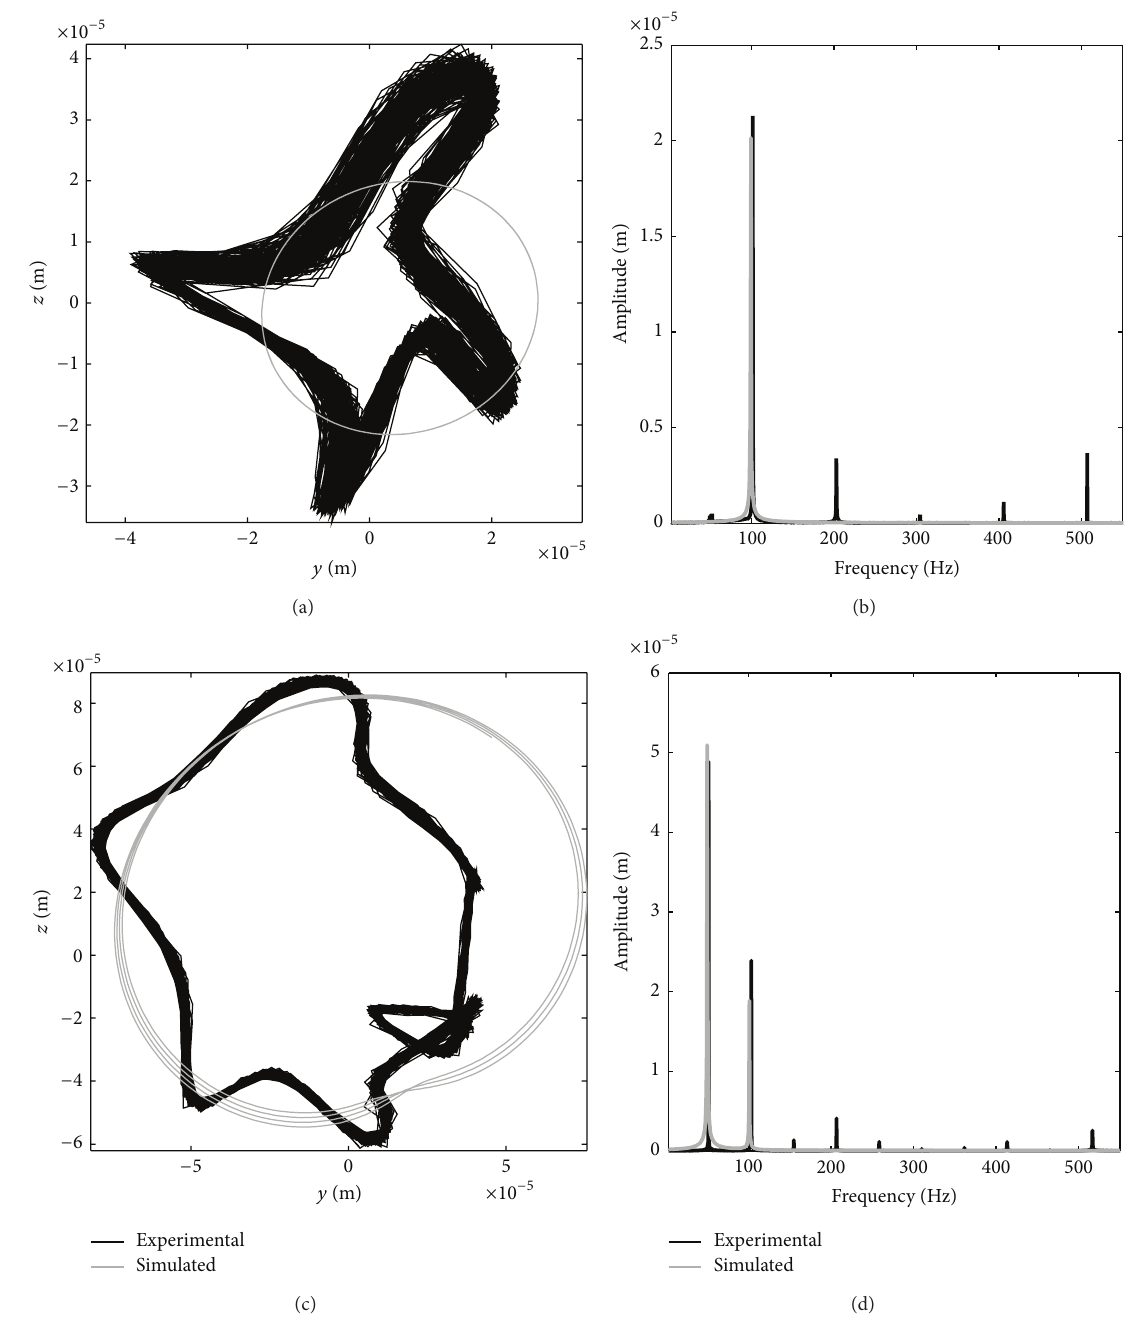
Figure 11: Experimental and simulated results for two conditions with fixed rotational speeds in configuration B: (a) orbits of the first condition (experimental 99Hz, simulated at 101Hz); (b) frequency spectrum of the first condition (experimental at 99Hz, simulated at 101Hz); (c) orbits of the second condition (experimental at 101.4Hz, simulated at 103.4 Hz); (d) frequency spectrum of the second condition (experimental at 101.4Hz, simulated at 103.4